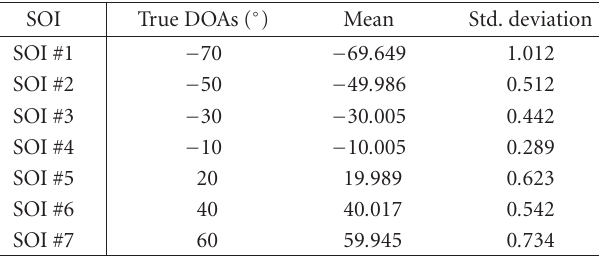
Table 2: Mean and standard deviations for the proposed method with seven SOI and seven interferer